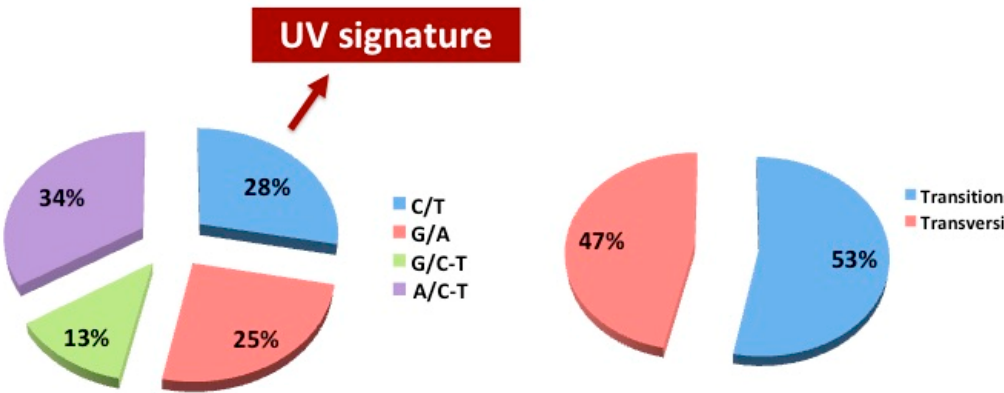
Figure 3. Mutation spectra in the analysed samples. ( left ) Pie chart shows the percentage distribution of nucleotide variations in the analysed genes. ( right ) Pie chart shows the percentage of transitions versus transversions mutations in the analysed genes.